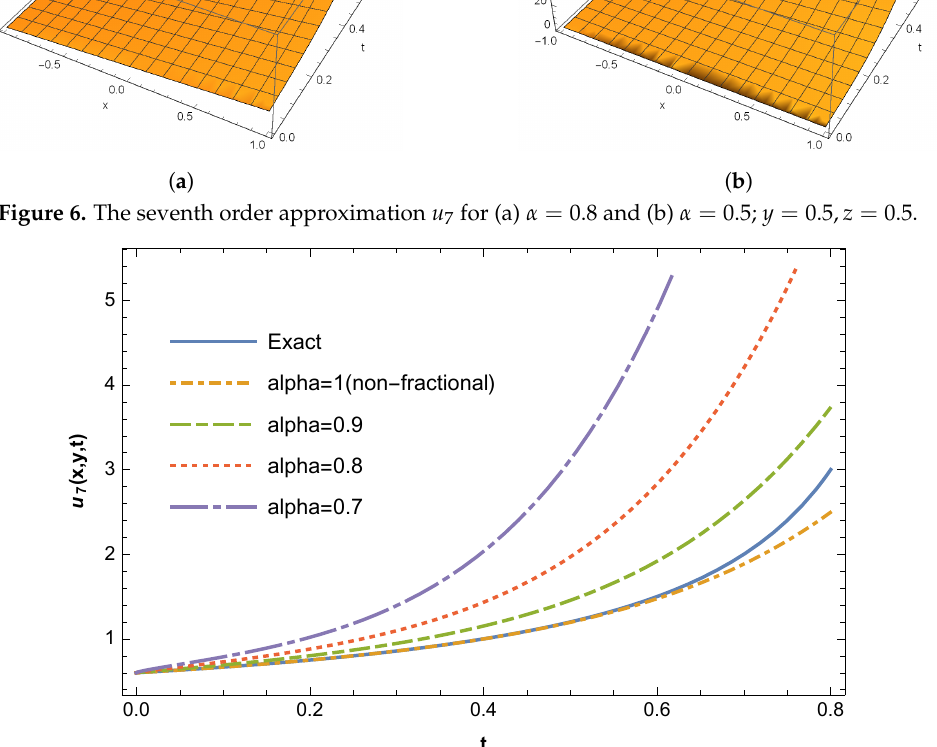
Figure 7. The seven term FRDTM solutions u 7 for α = 1 ( exact ) ,0.9,0.8,0.7; t ∈ [ 0,0.8 ] , and y = 0.2, z = 0.1, x = 0.3.